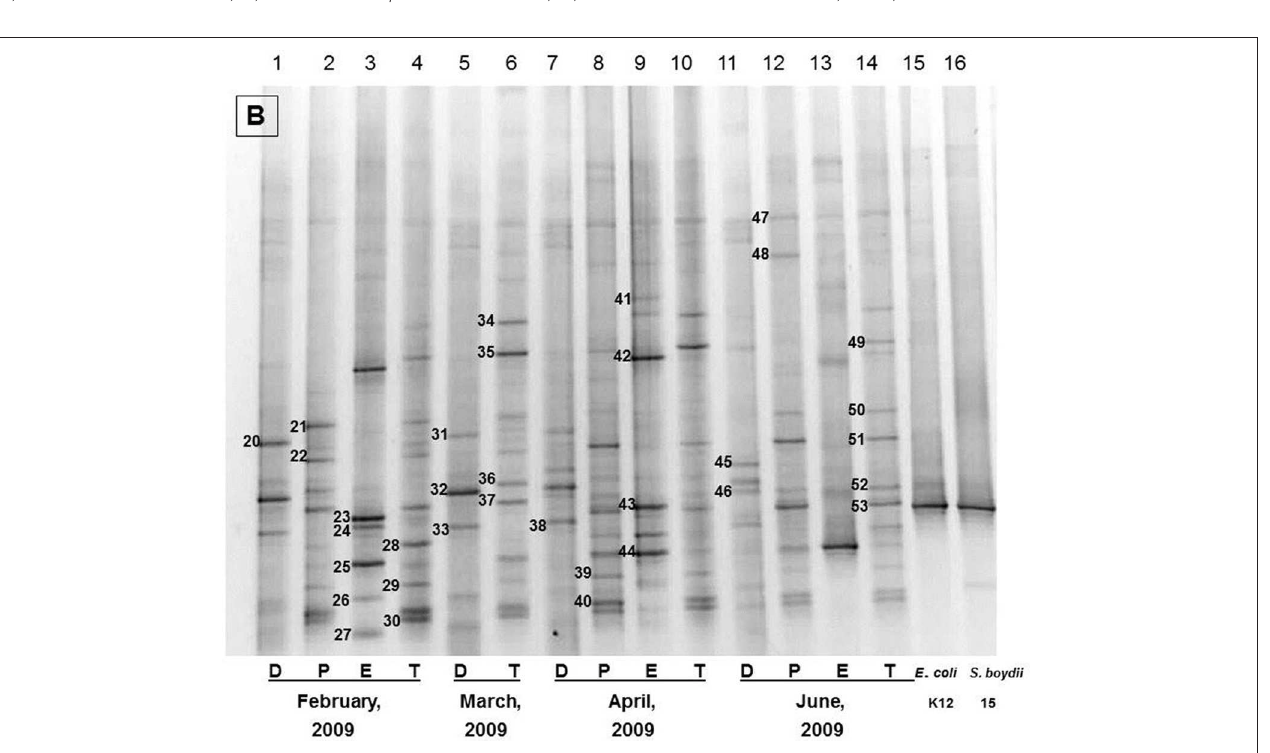
Frontiers in Public Health |